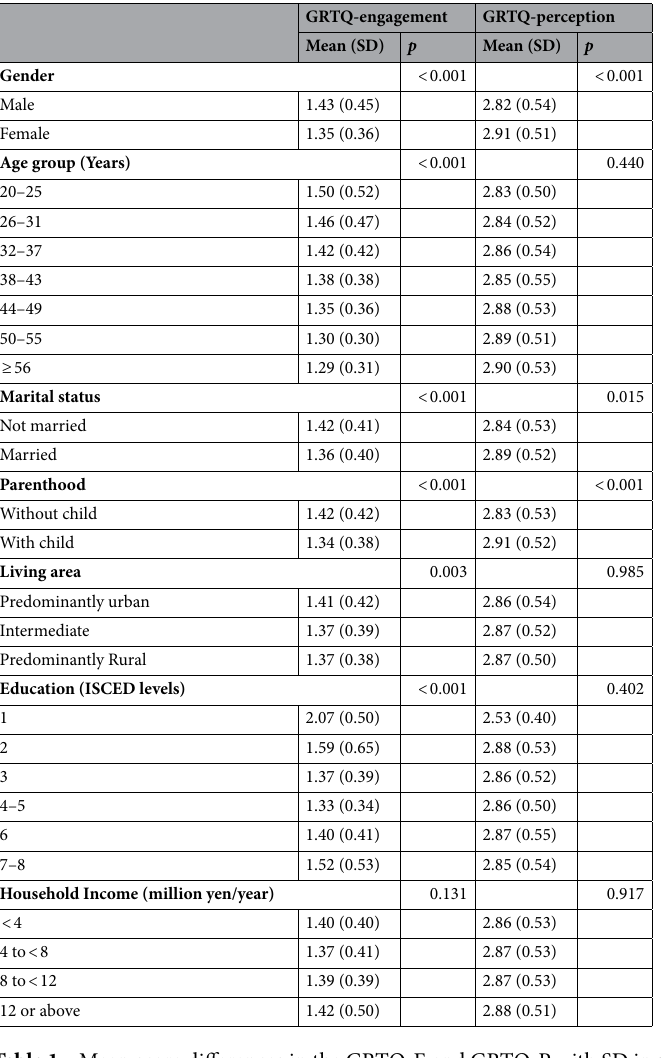
Table 1. Mean score differences in the GRTQ-E and GRTQ-P with SD in parentheses (n = 2984). Group differences were compared by Mann–Whitney U-test, Kruskal–Wallis test and Dunn Test for variables (tied ranks adjusted). All tests were two-tailed, with an alpha level of .05. All group differences remained significant after Bonferroni-adjustment for multiple testing except marital status in GRTQ-P. There were no missing data for all variables.